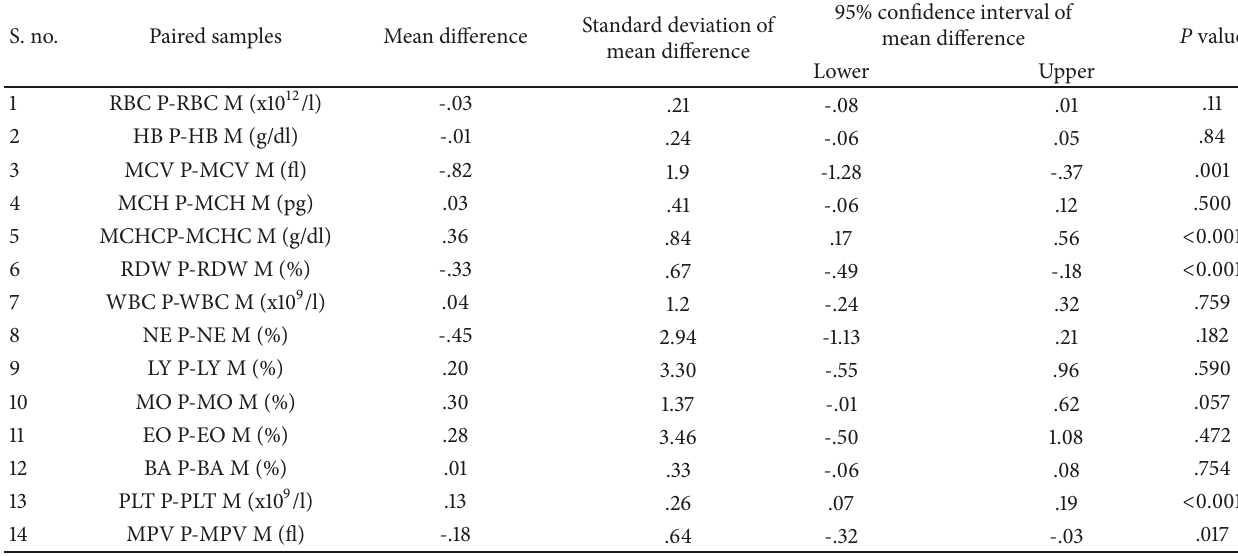
Table 1: Summary of the differences in CBC between pneumatic tube samples and hand delivered samples. S.